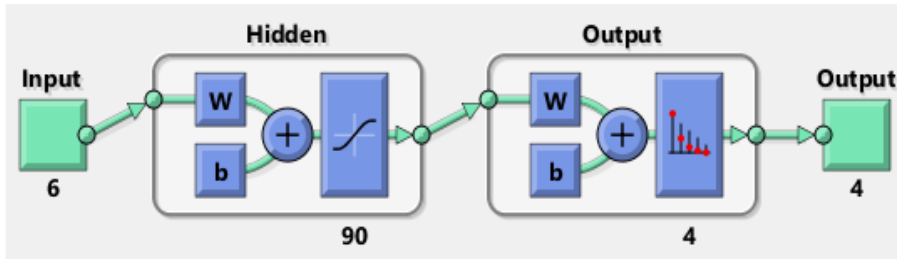
Figure 2. Network structure for <complication class>.